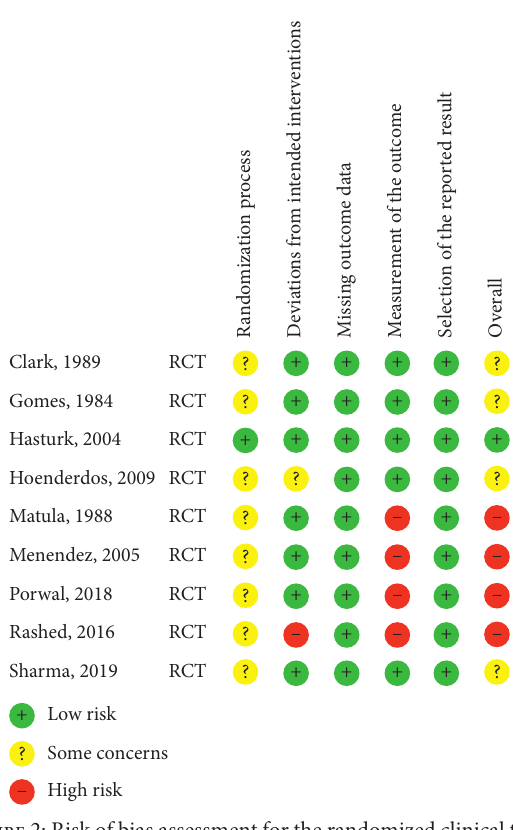
Figure 2: Risk of bias assessment for the randomized clinical trials.